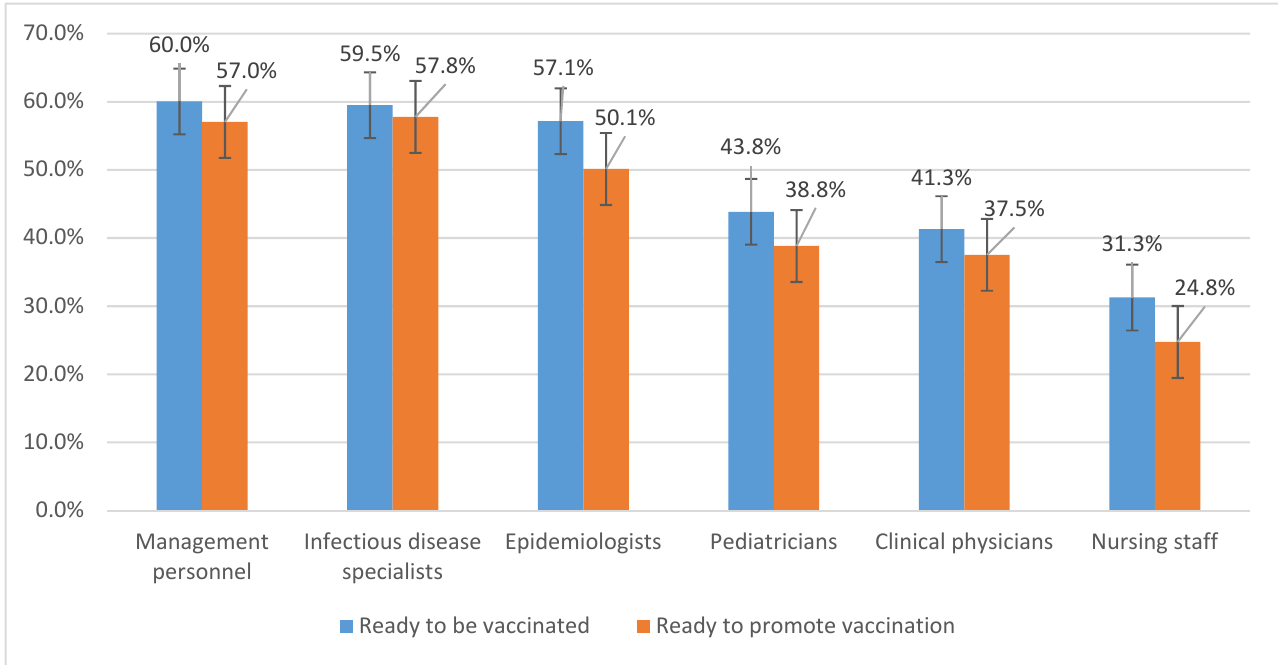
Figure 1. The adherence of health care providers to vaccination against COVID-19 .